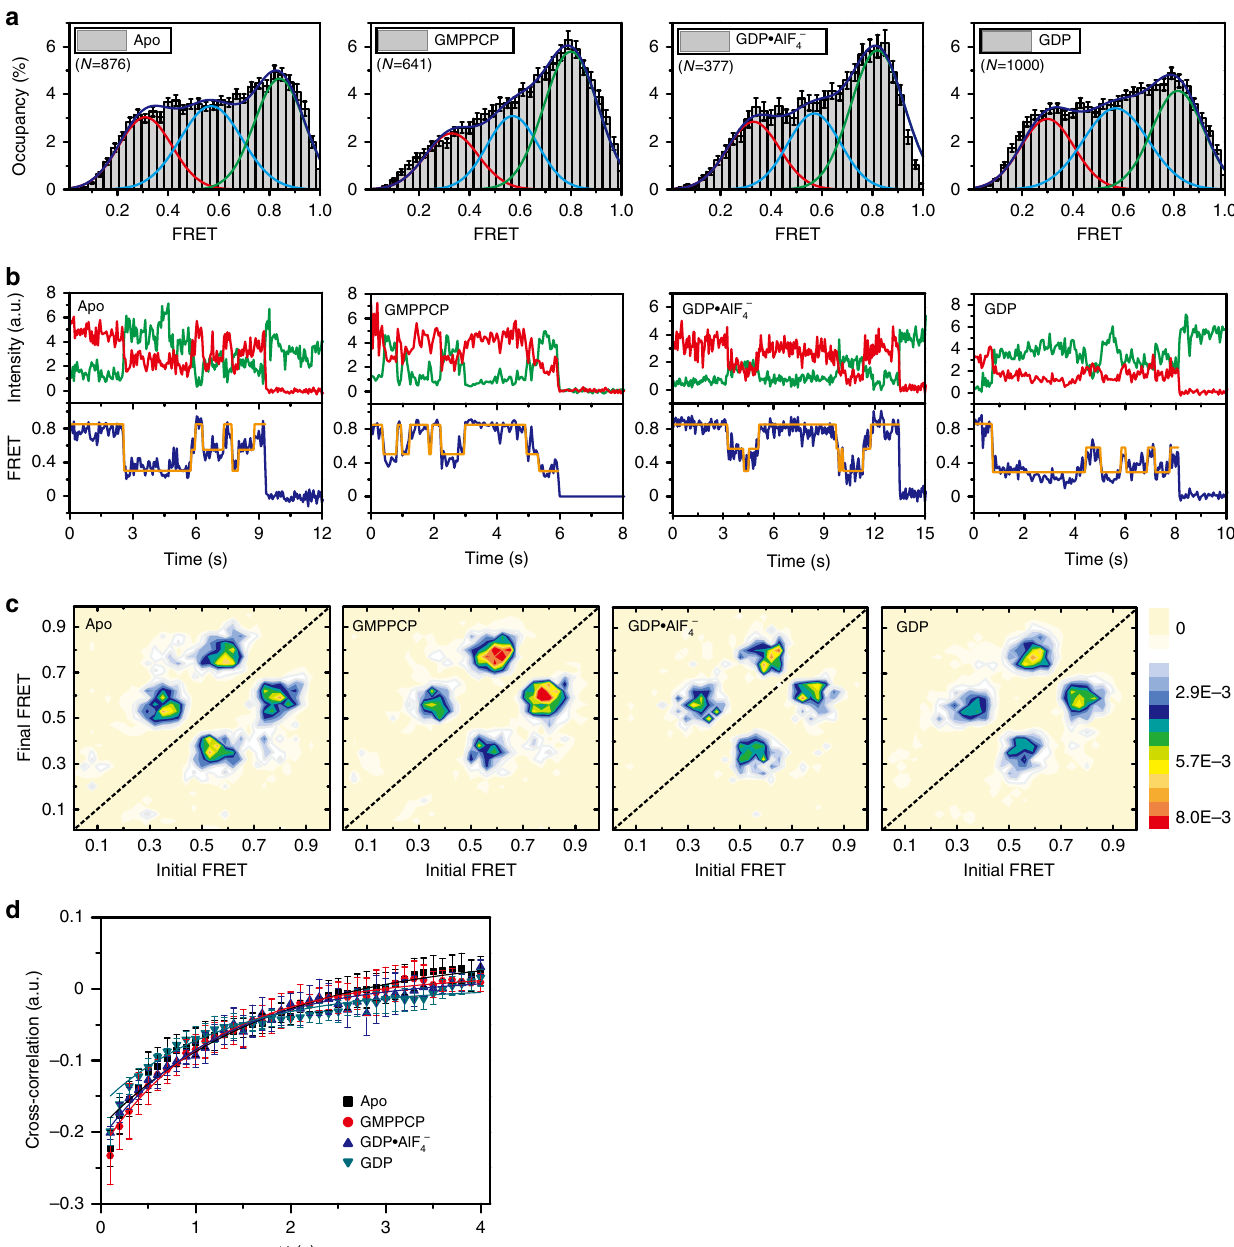
Figure 4 | Conformational dynamics in the BSE-stalk region. ( a ) Histograms of FRET data from the mutant MxA MO2 -RR. Error bars indicate s.d. of 1,000 bootstrap samples of the FRET traces. Gaussian curves for low-, medium- and high-FRET states are coloured red, marine and green, respectively. ( b ) Representative traces for the mutant MxA MO2 -RR in different nucleotide-loading conditions. Traces and idealization are coloured as in Fig. 3d. ( c ) TDPs as in Fig. 4a (different nucleotide-loading conditions are indicated). ( d ) Cross-correlation analysis shows similar dynamics in different nucleotide-loading conditions. Error bars indicate s.d. of results from five independent experiments. TDP, transition density